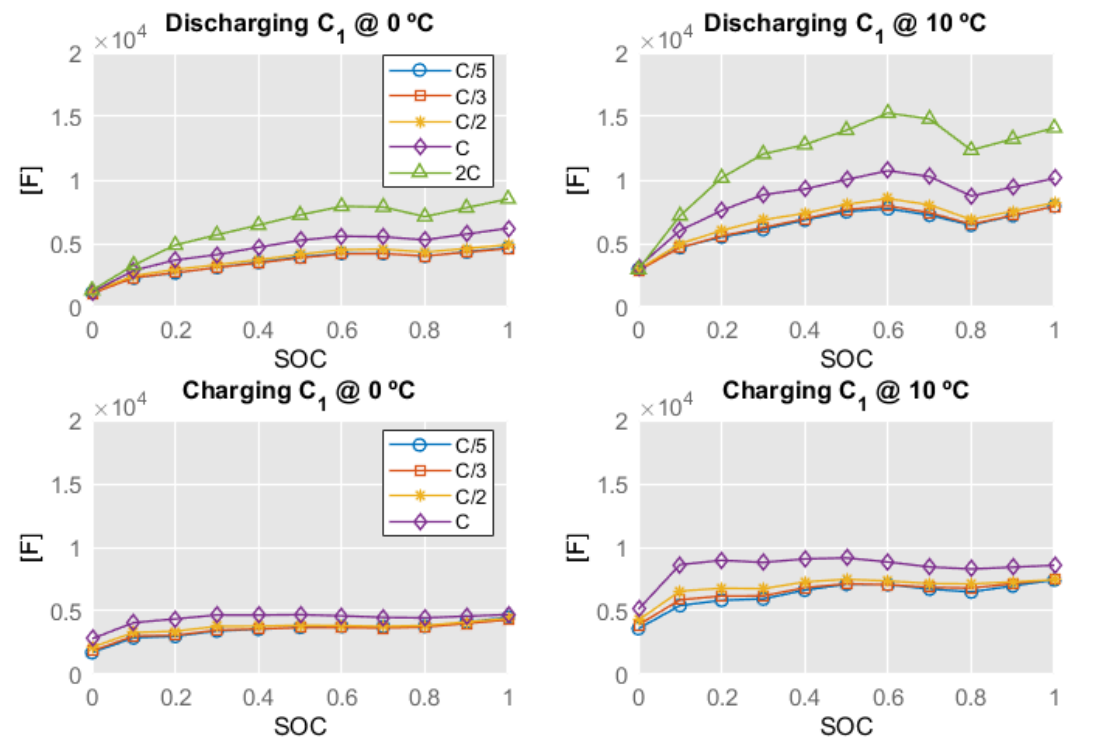
Figure 9. Double-layer capacitance ( C 1 ) in charge and discharge from HPPC test @ 0 – 10 °C.